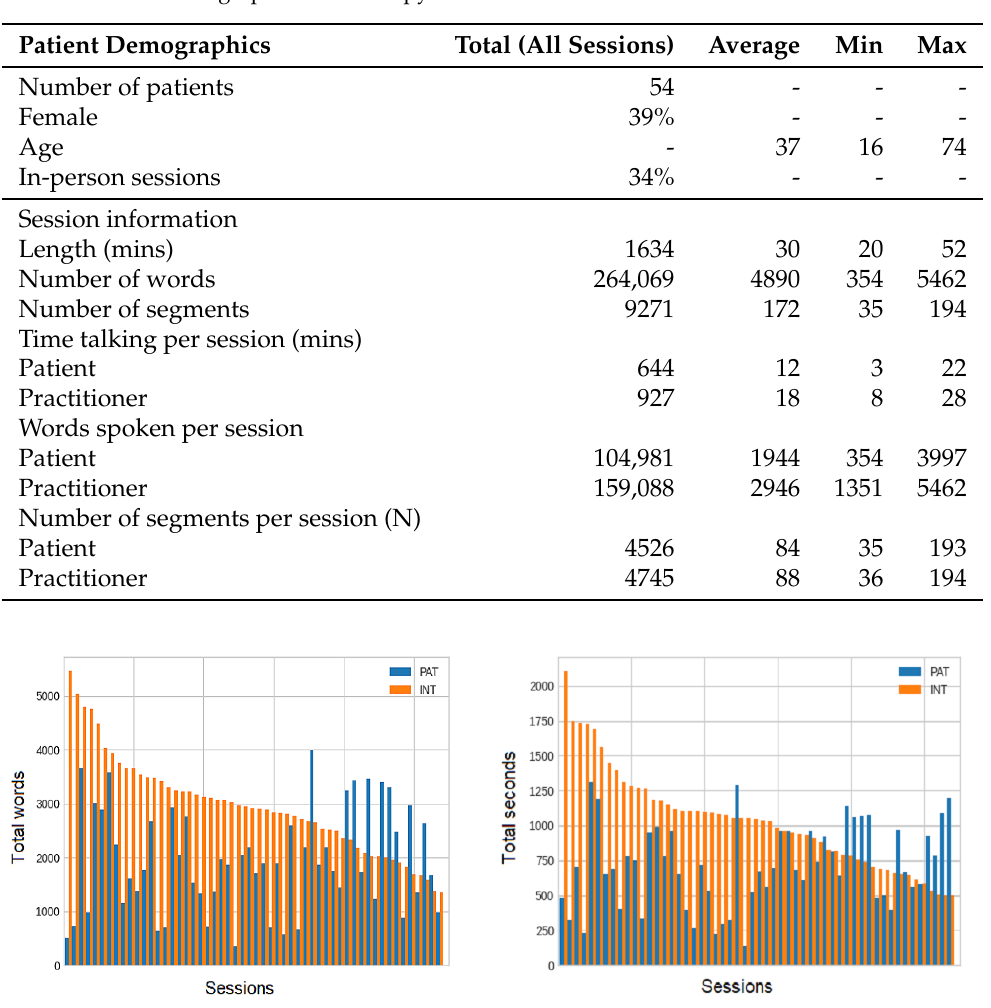
Table 1. Patient demographics and therapy session information for the GSHTS dataset.